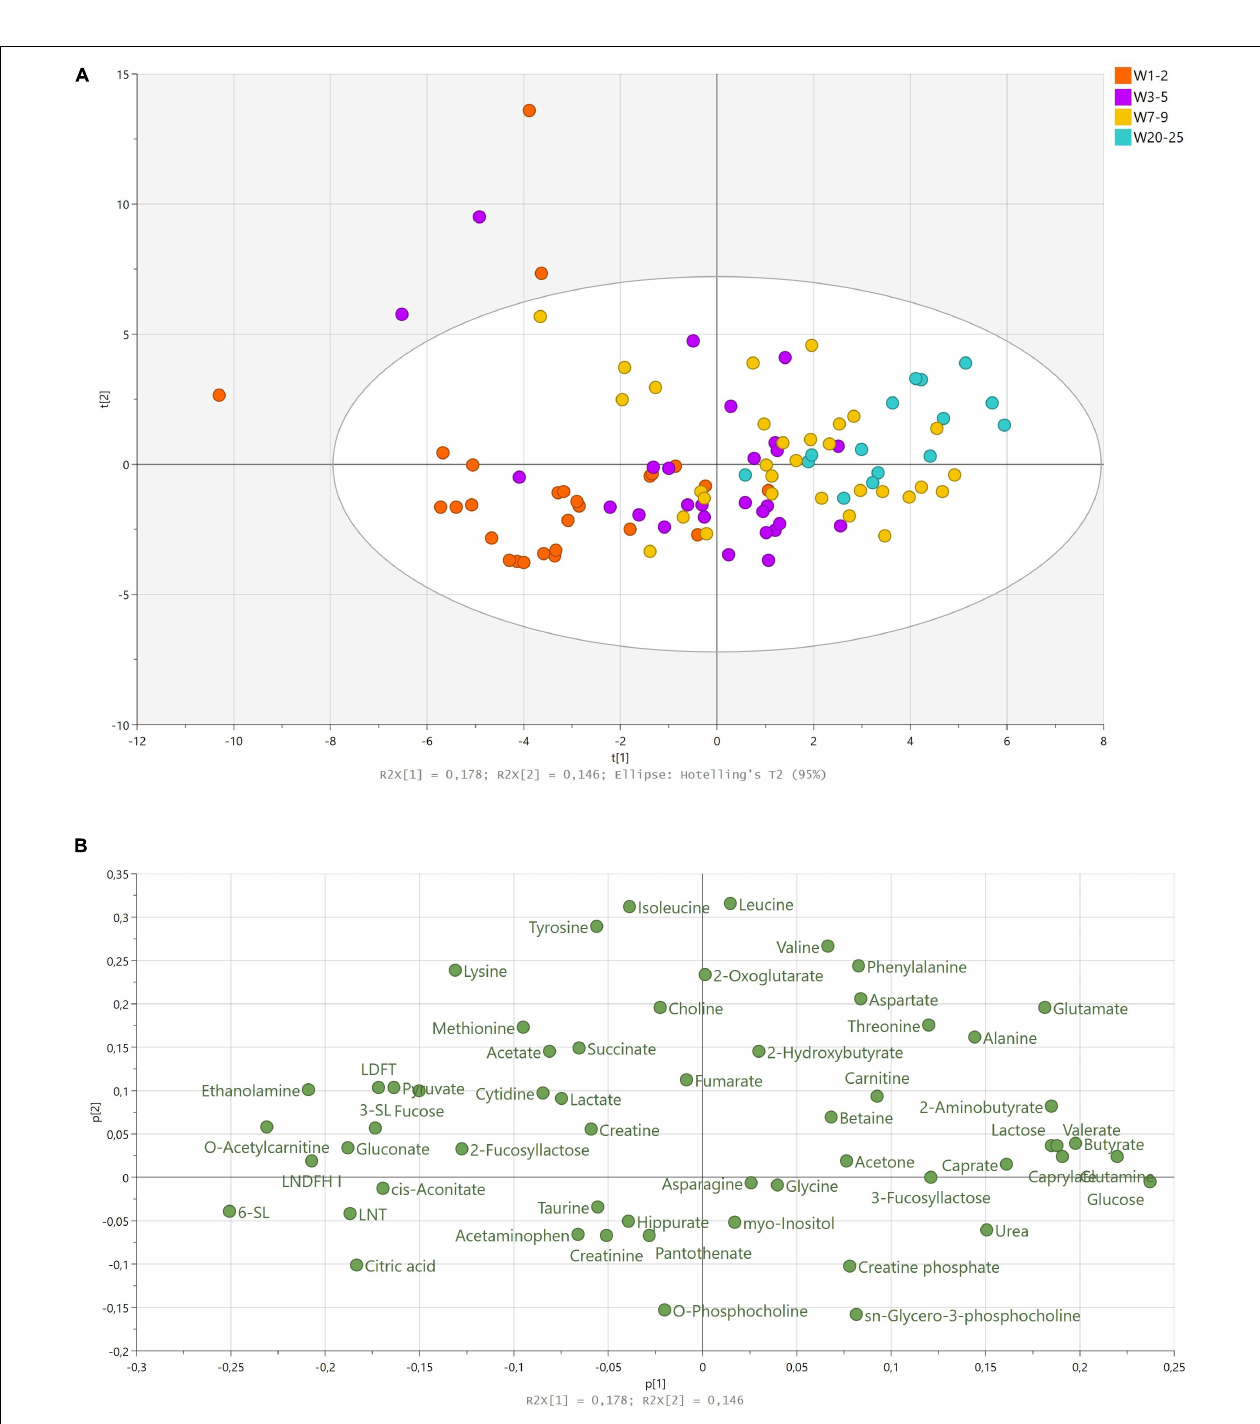
FIGURE 1 | Principal component analysis of human milk samples ( n = 100) from term deliveries collected from weeks 1 to 25 postpartum. (A) Scores scatter plot of observations collected colored according to sampling time postpartum. The legend denotes color-coded time points from weeks 1–2 to 20–25. (B) Corresponding loadings scatter plot of variables measured. Abbreviations: LDFT; lactodifucotetraose, LNDFH; lacto-N-difucohexaose, LNT; lacto-N-tetraose, SL; sialyllactose, W; week